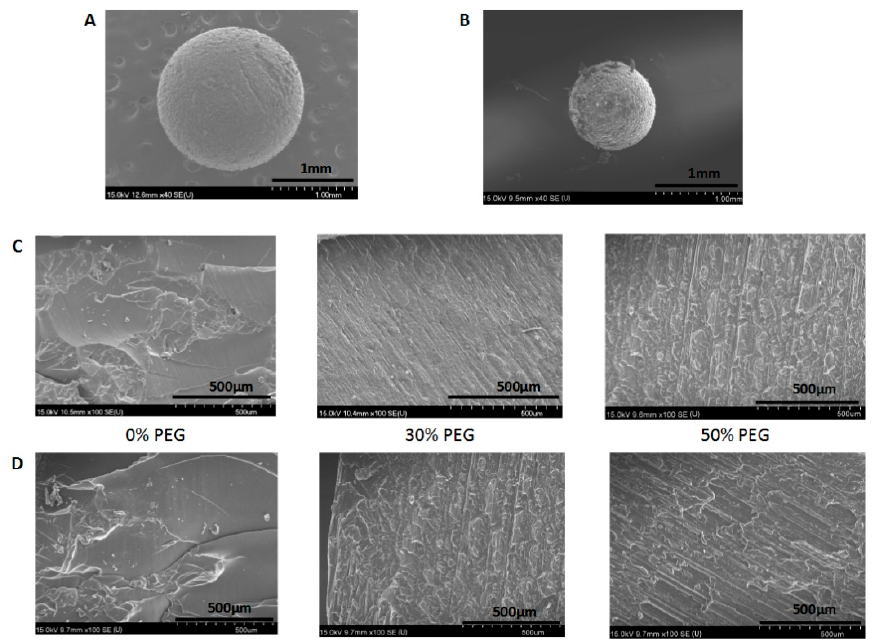
Figure 7. Scanning electron microscopy images of printed pellets: ( A ) overall morphology of the 2 mm pellets; ( B ) overall morphology of the 1 mm pellets; ( C ) the cross-section of 2 mm pellets with different contents of PEG400; ( D ) the cross-section of 1 mm pellets with different contents of